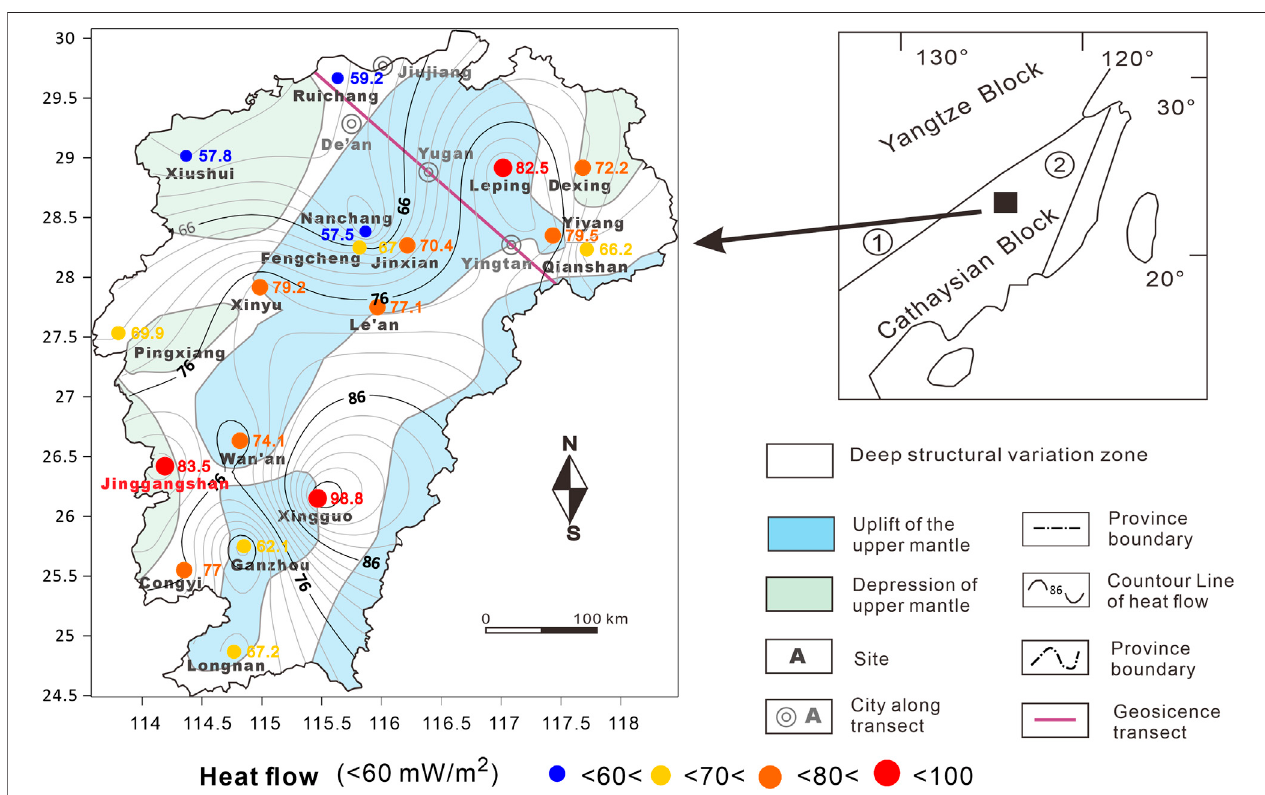
FIGURE 1 | Terrestrial heat fl ow distribution and geotectonic map of Jiangxi Province (modi fi ed after Li et al. (1992) and Shen et al. (2009)).